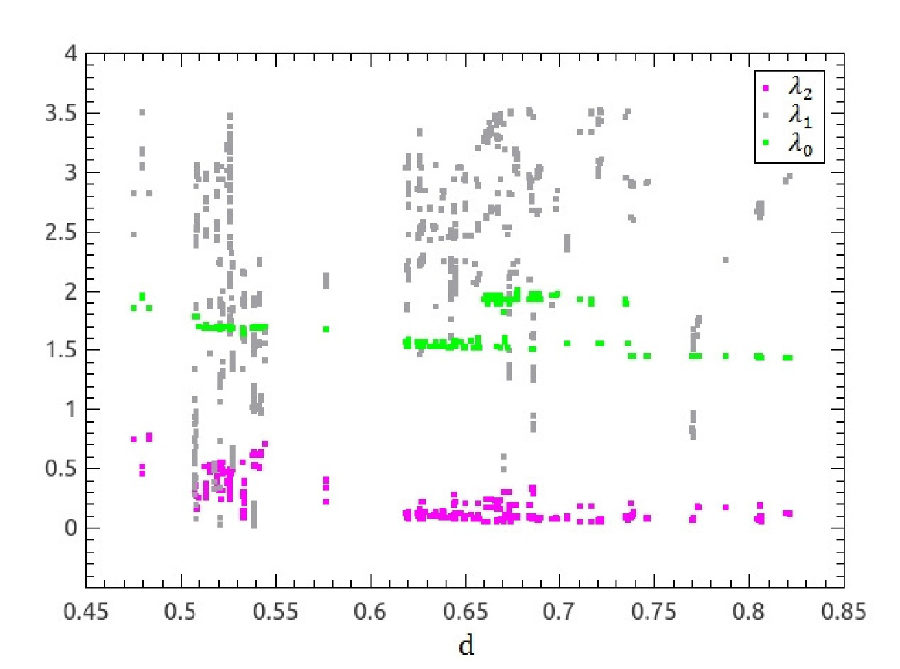
Figure 4 . The scattering plots of survived points for the de(cid:13)ection parameter d versus